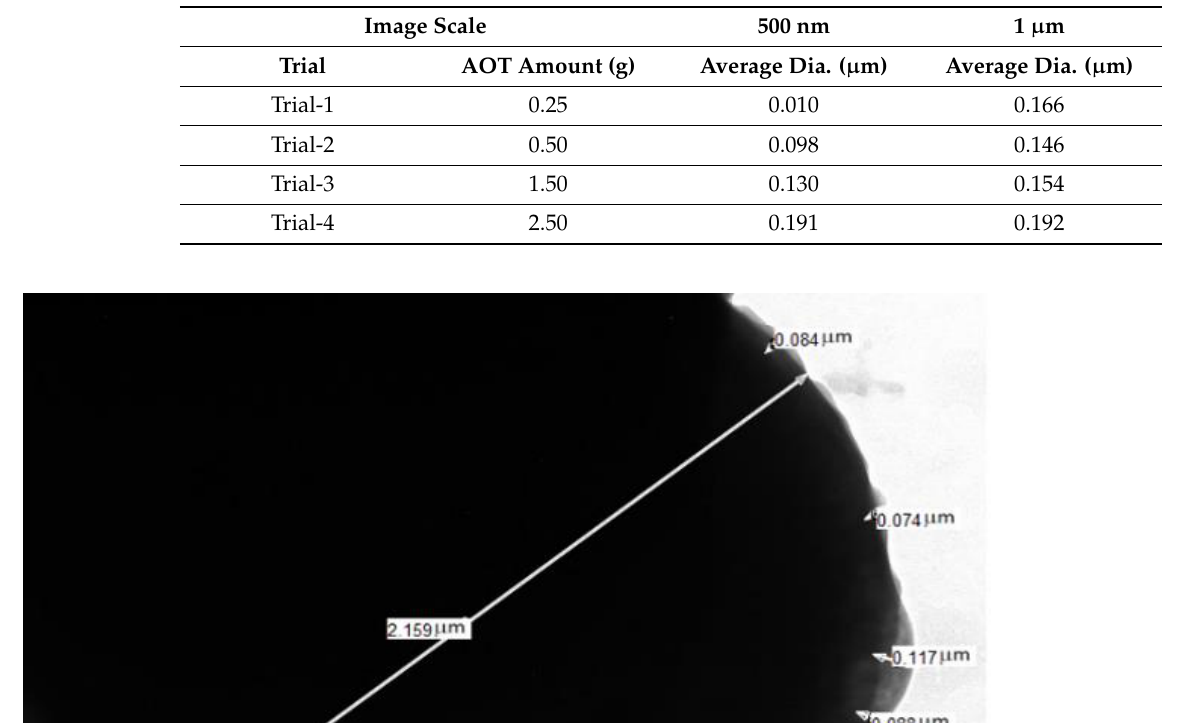
Table 2. Microcapsule minimum, maximum, and average diameters at different image scales.